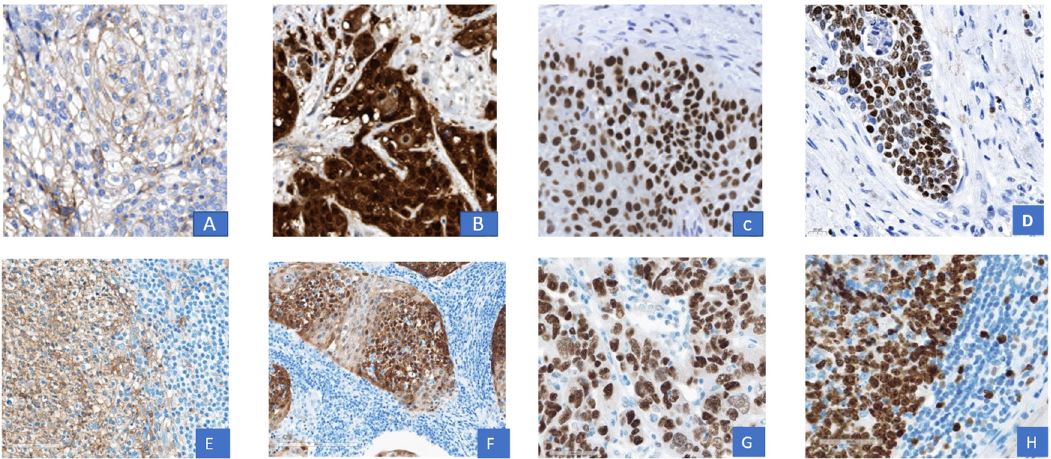
Figure 1. Representative immunohistochemistry for tumoral PD-L1, P16, p53 and KI-67. Representative histology sections show a membranous tumoral PD-L1 expression ( A ), a positive nuclear and cytoplasmatic p 16 staining ( B ), a positive p53 tumor cell nuclei overexpression ( C ) and a strong KI-67 nuclear staining by immunohistochemistry ( D ); validated control sections according to ISO 17020: membranous PD-L1 expression ( E ), nuclear and cytoplasmatic staining of p 16 ( F ), p 53 nuclear overexpression ( G ), KI-67 nuclear and cytoplasmatic staining ( H ) by immunohistochemistry. Magnification 400×. Table 5. PD-L1 Table 3. Multivariate analysis of the prognostic impact of age, lymph node metastases, hemangiosis, lymphangiosis and p16+ staining.